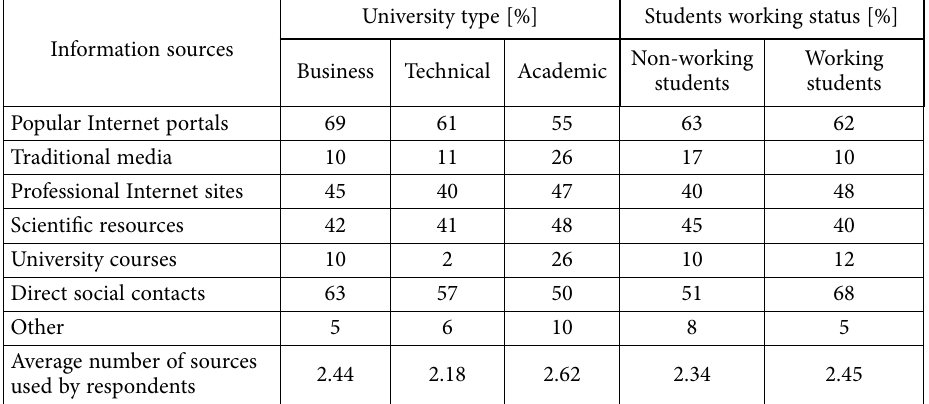
Table 5. Information sources in relation to university type and working